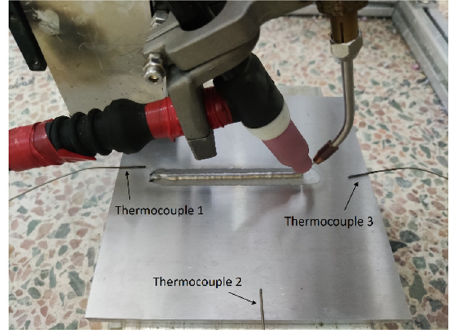
Figure 1. Placement of thermocouples.